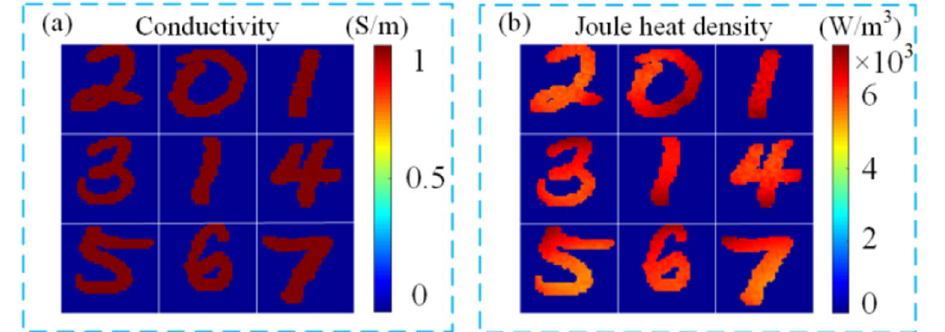
Figure 5. Calculation results of electric field ( a ) conductivity; ( b ) Joule heat